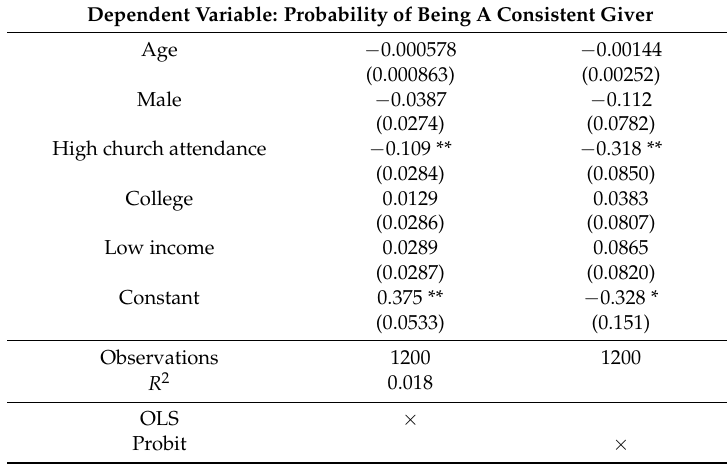
Table A3. Regression results for demographic differences between consistent and varying givers. 1